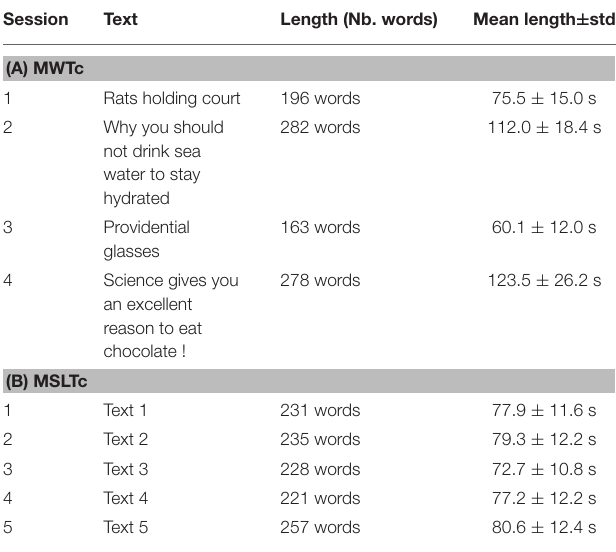
TABLE 3 | Brief description of the texts read by the patients of the Maintenance of Wakefulness Test Corpus (MWTc) (A) and Multiple Sleep Latency Test corpus (MSLTc) (B)